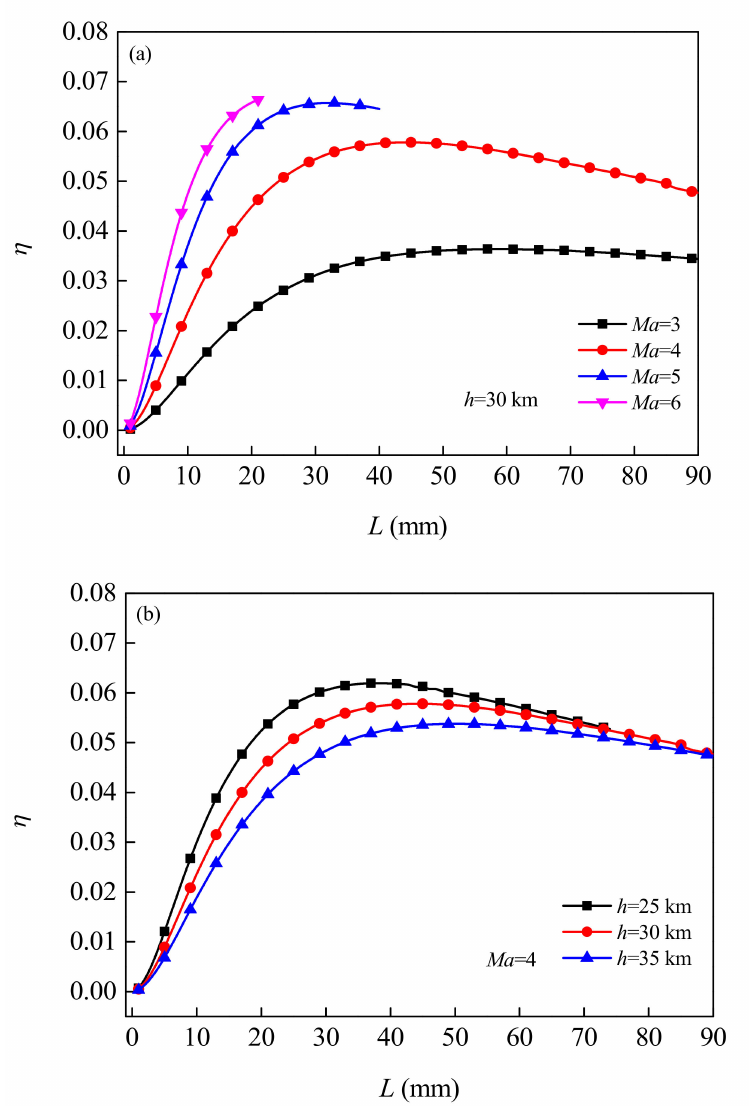
Figure 9. Variation of the conversion efficiency of TEGs changing with the length of the TE leg under different flight Mach numbers ( a ) and flight altitudes ( b